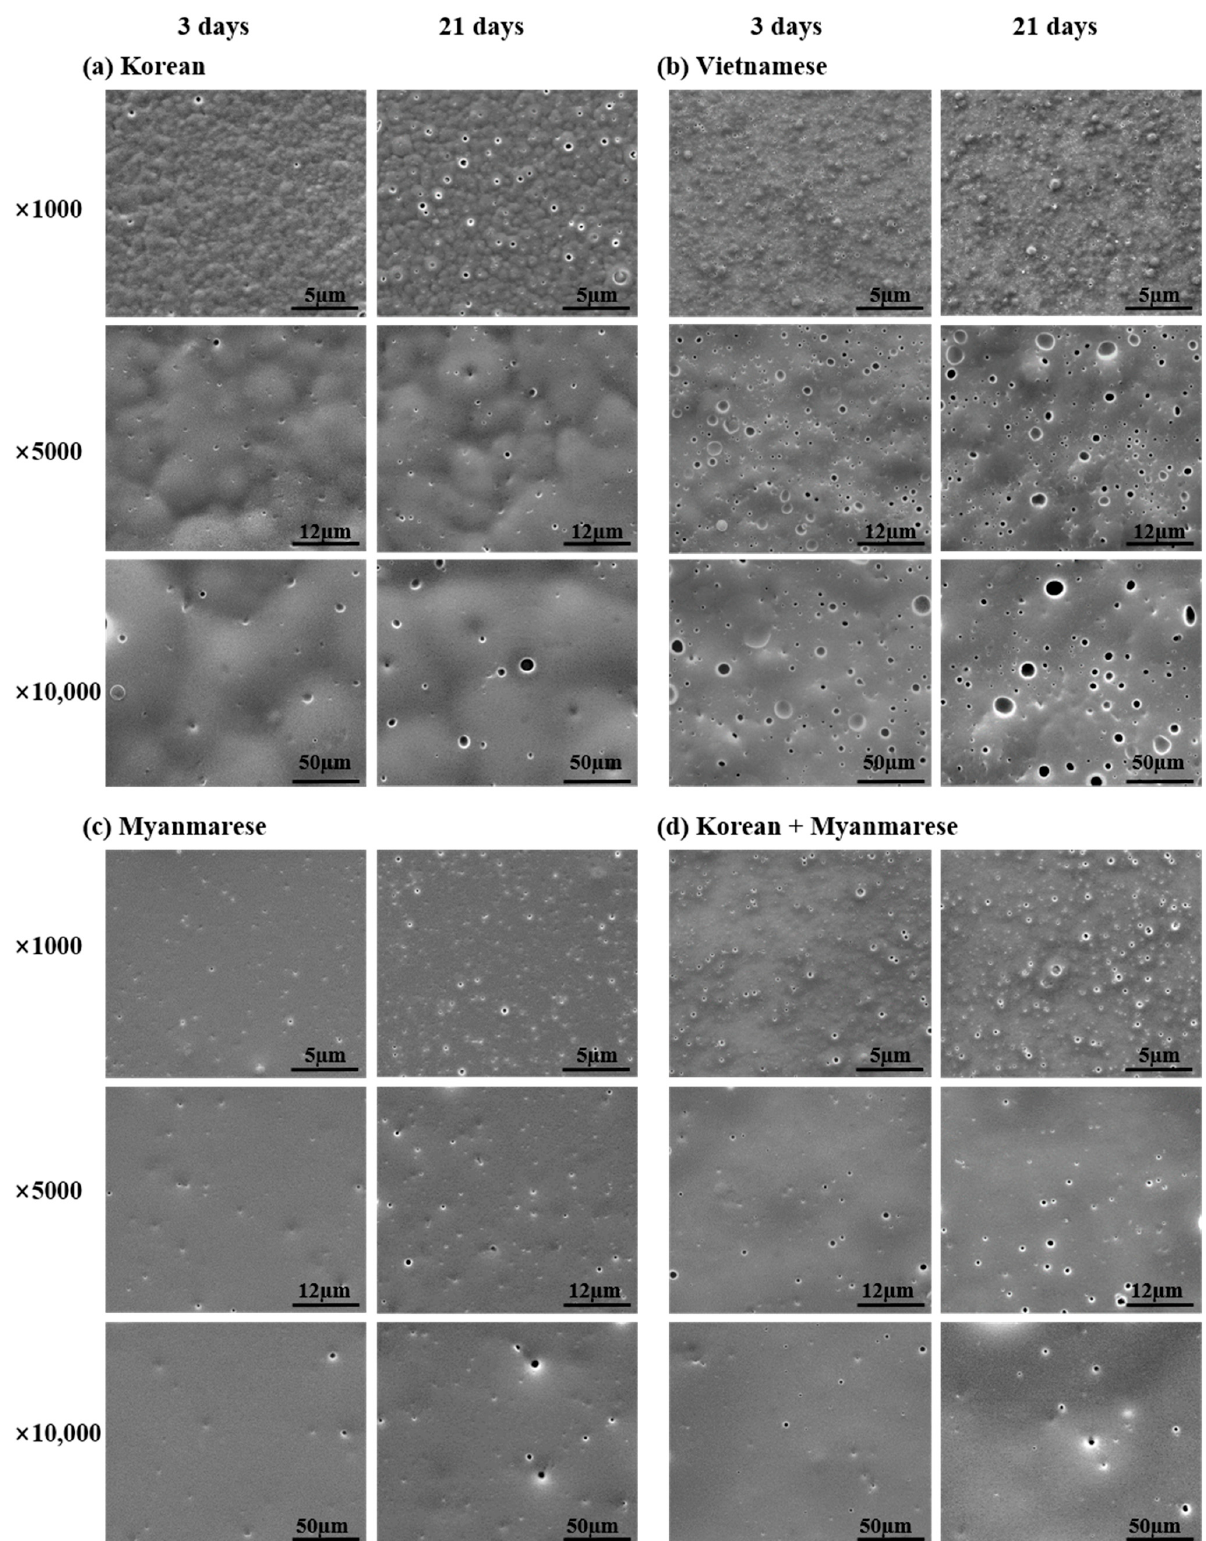
Figure 2. FESEM images of Oriental lacquers as a function of drying time: ( a ) Korean, ( b ) Vietnamese, ( c ) Myanmarese, ( d ) Korean/Myanmarese mixture (1/1, w / w ).